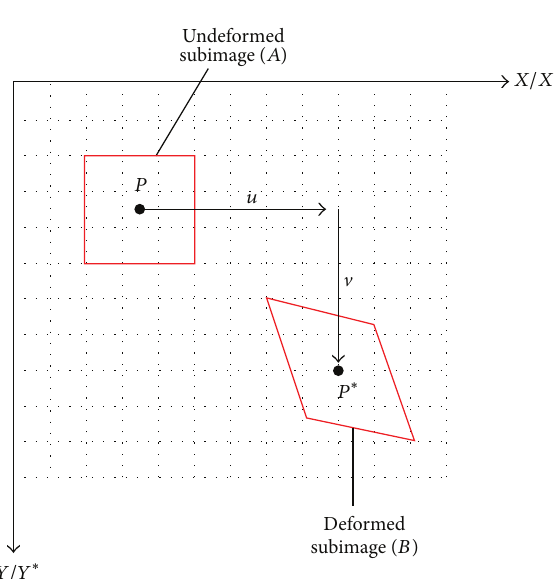
Figure 2: Schematic drawing of relative location of deformed and undeformed